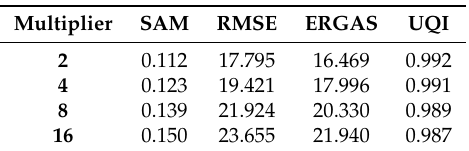
Figure 17. Image differences between the generated images and the original NIR (band 5) and SWIR (bands 6 and 7) for the Landsat final set brought to 30 m pixel size following the Wald’s protocol. Table 8. Landsat spectral quality indexes between the generated and original spectral compositions resized to 15 m pixel resolution.